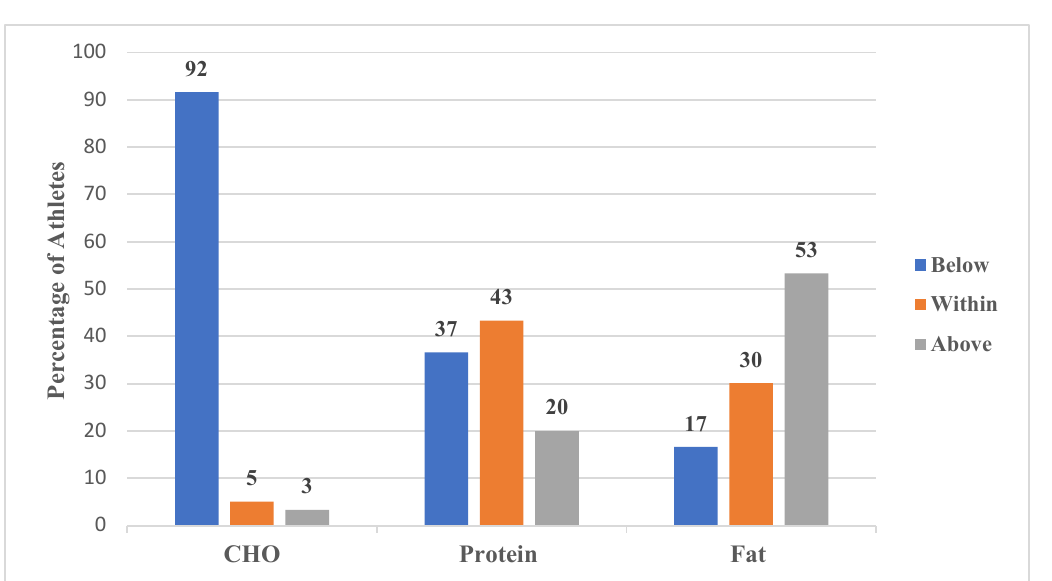
Figure 2. Macronutrient intake of athletes.